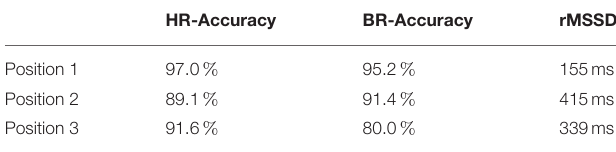
TABLE 4 | Subject 4: Accuracy of HR and